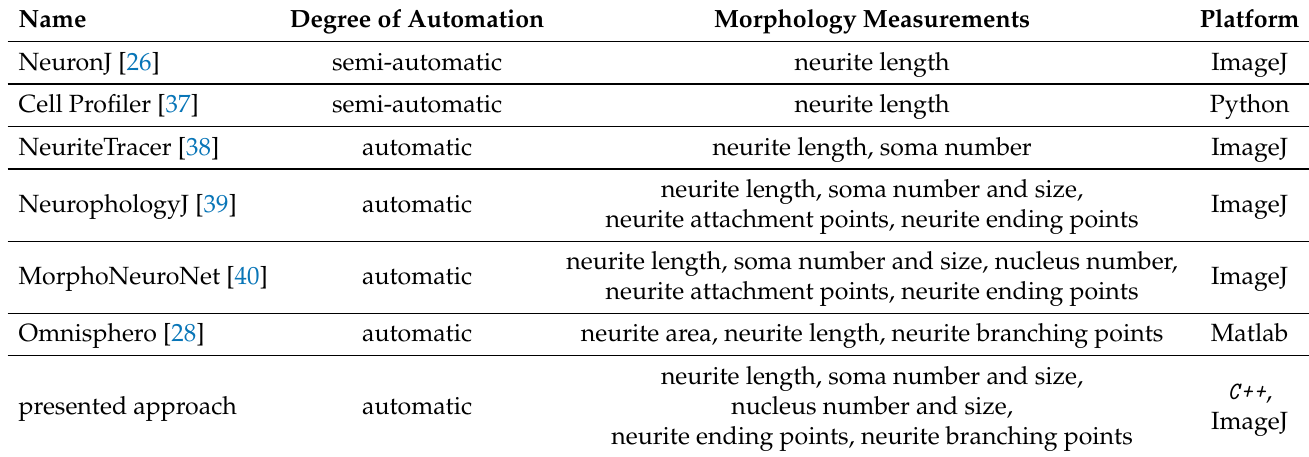
Table 1. neurite quantification software for high throughput screening of 2D immunocytofluorescence image data.